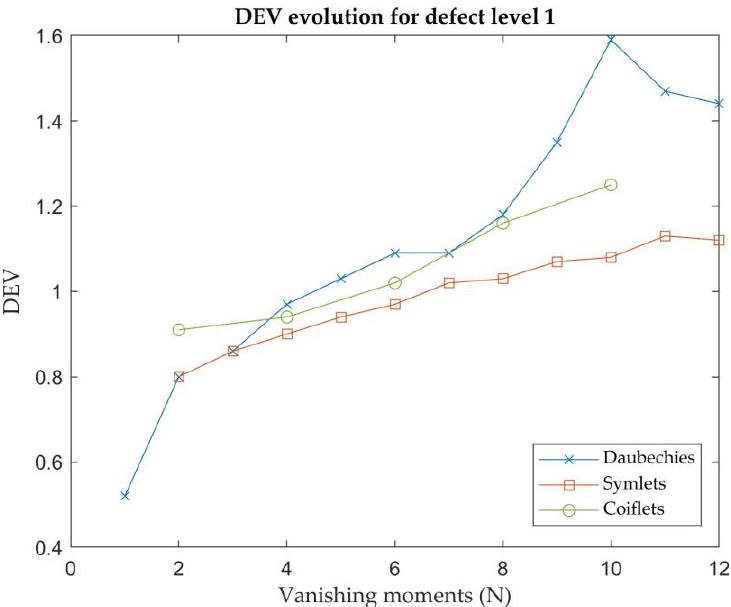
Figure 5. DEV evolution for defect level 1 and different mother wavelets.